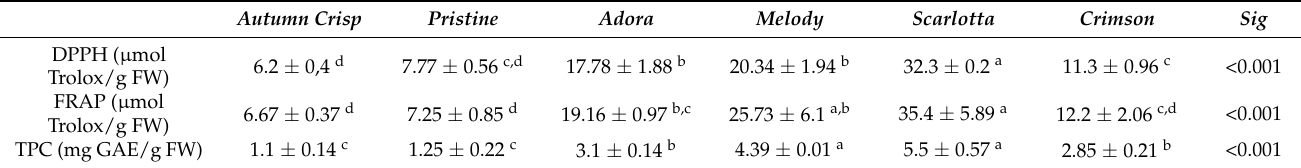
Table 3. Seedless grape antioxidant